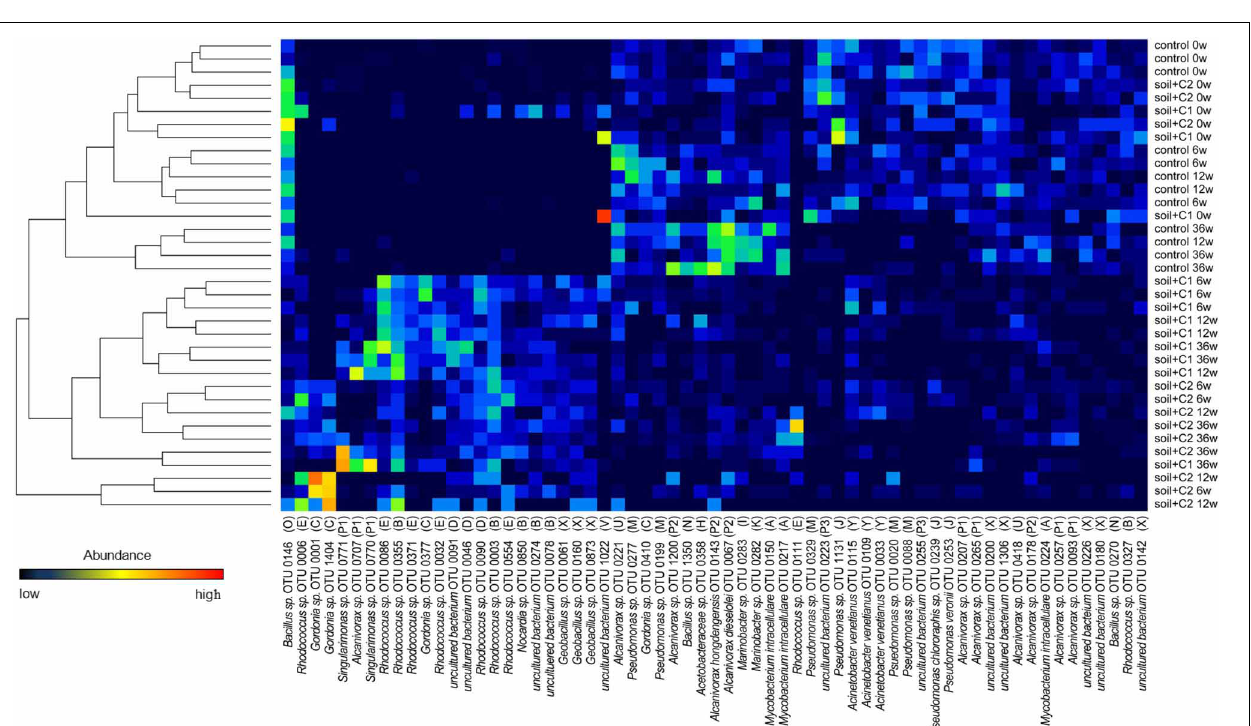
visualized by a tree. The number after the sample name indicates the incubation time in weeks. The according cluster of each OTU is specified in